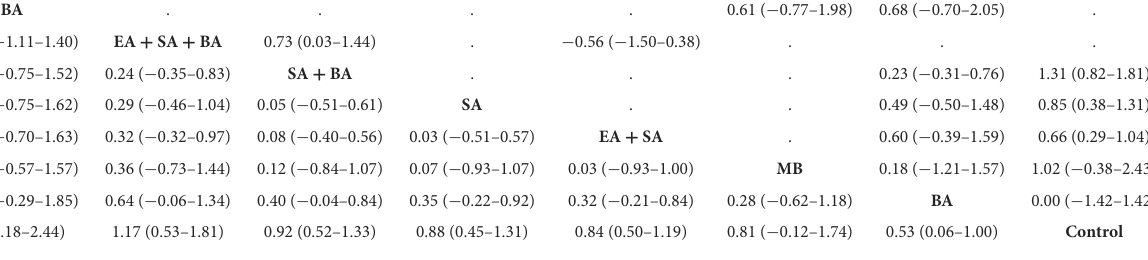
TABLE 2 Results of network meta-analysis for all possible treatment effects (cognitive function).